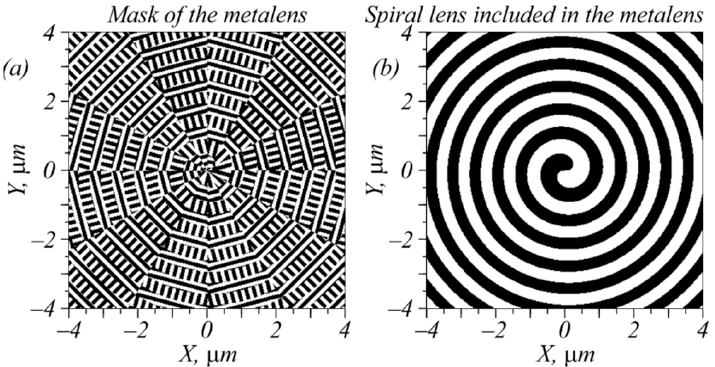
Figure 1. A view of the metalens under consideration, which had a size of 8 × 8 μ m ( a ), and a spiral zone plate included in the metalens ( b ). zone plate included in the metalens ( b ).